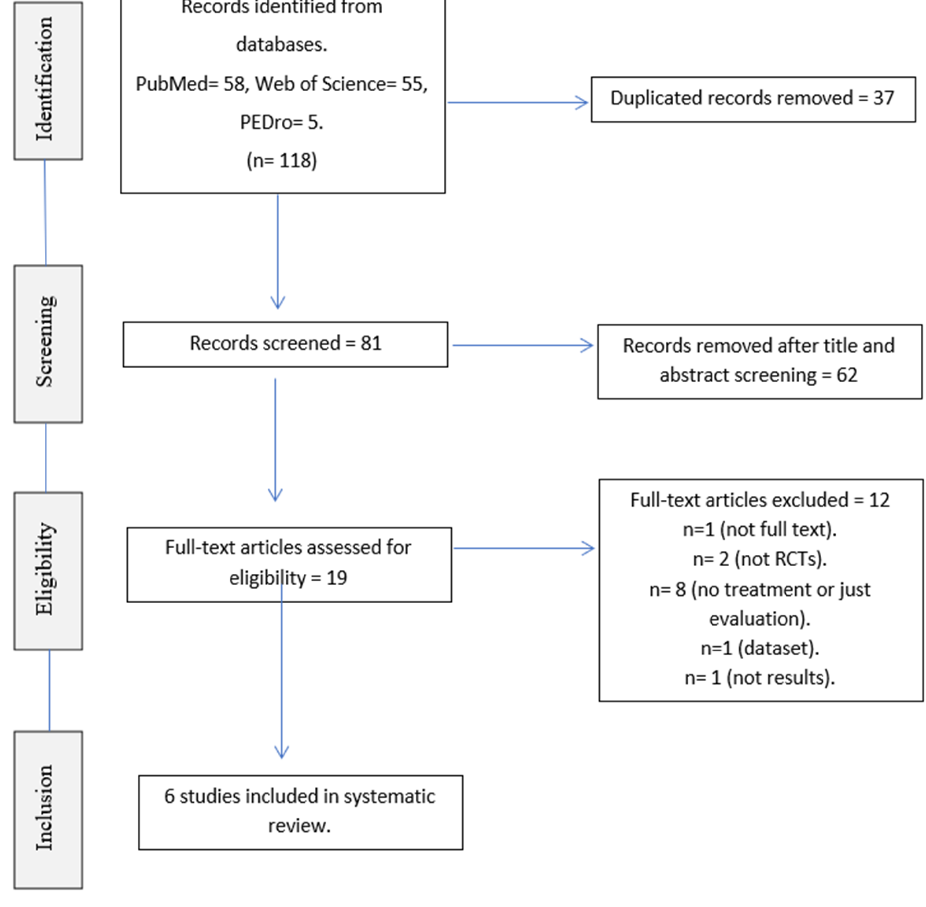
Figure 1. PRISMA flowchart.